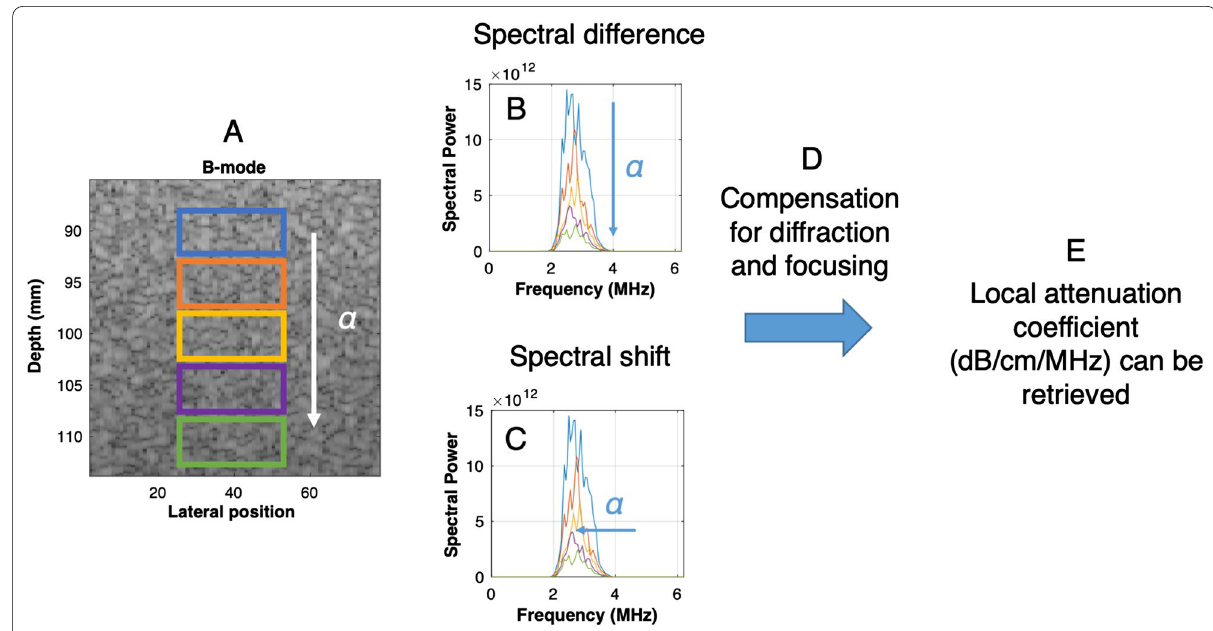
Fig. 12 Schematic representation of contemporary local attenuation algorithms. a A region of interest within a B-mode image is discretized into rectangular measurement windows to locally estimate the attenuation coefficient α . b Spectral difference method, ( c ) spectral shift method, ( d ) compensation for diffraction and ultrasound system focusing using the reference phantom method, and ( e ) estimation and display of the local attenuation coefficient